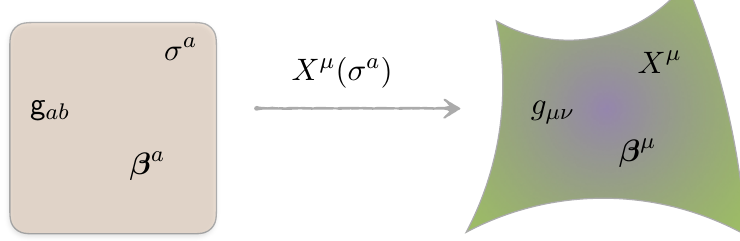
Figure 3 . Illustration of the data for hydrodynamic sigma models as described in [2]. The physical degrees of freedom are captured in the target space maps X (cid:22) ( (cid:27) ) which are the hydrodynamic pion (cid:12)elds. The worldvolume geometry is equipped with a reference thermal vector (cid:12)eld (cid:12) a , which pushes forward to the physical thermal vector in spacetime, while the spacetime metric pulls back to the worldvolume metric g ab